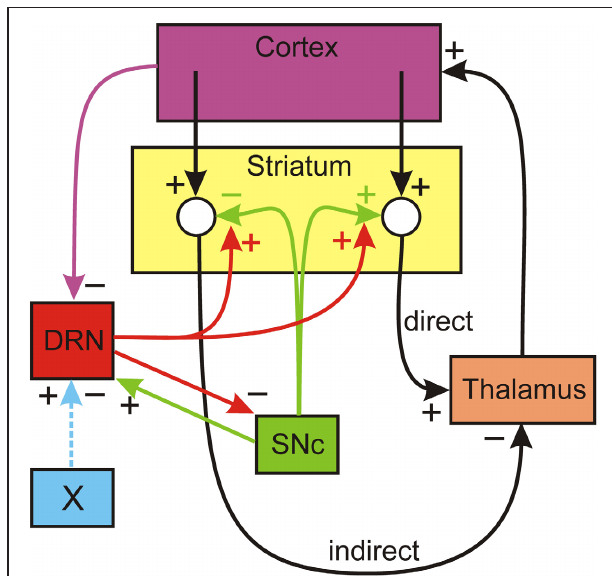
FIGURE 1 | The influence of the DRN on the direct and indirect pathways. Dopaminergic neurons of the SNc inhibit the indirect pathway and stimulate the direct pathway from the cortex to the thalamus. Serotonin from the DRN projections to the striatum increase DA release and projections from the cortex inhibit DRN firing. The details of basal ganglia BG circuitry in the direct and indirect pathways is omitted. References for the influences are given in the text. There are many descending projections to the DRN; nucleus X represents one of these that may excite or inhibit the DRN.